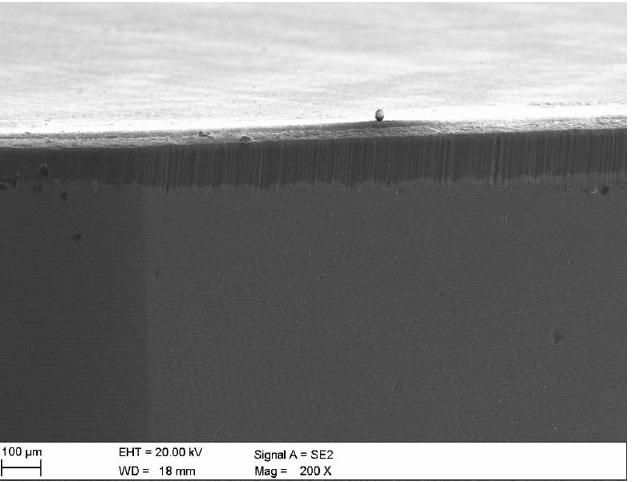
Figure 4. Flank wear character of the Al 2 O 3 ceramics reinforced with SiC whiskers after 50 min turning of grey cast iron.